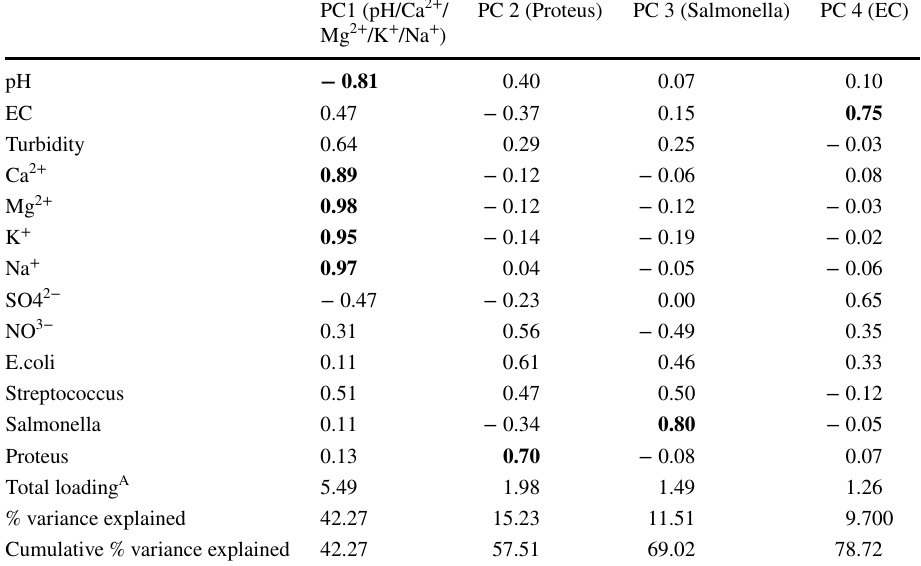
Table 3 Principal component analysis generated based on factor loading ( n = 18)